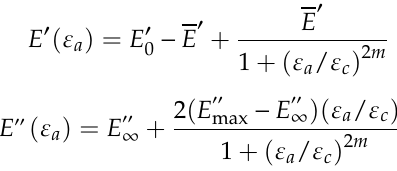
corresponding to the maximum loss modulus c